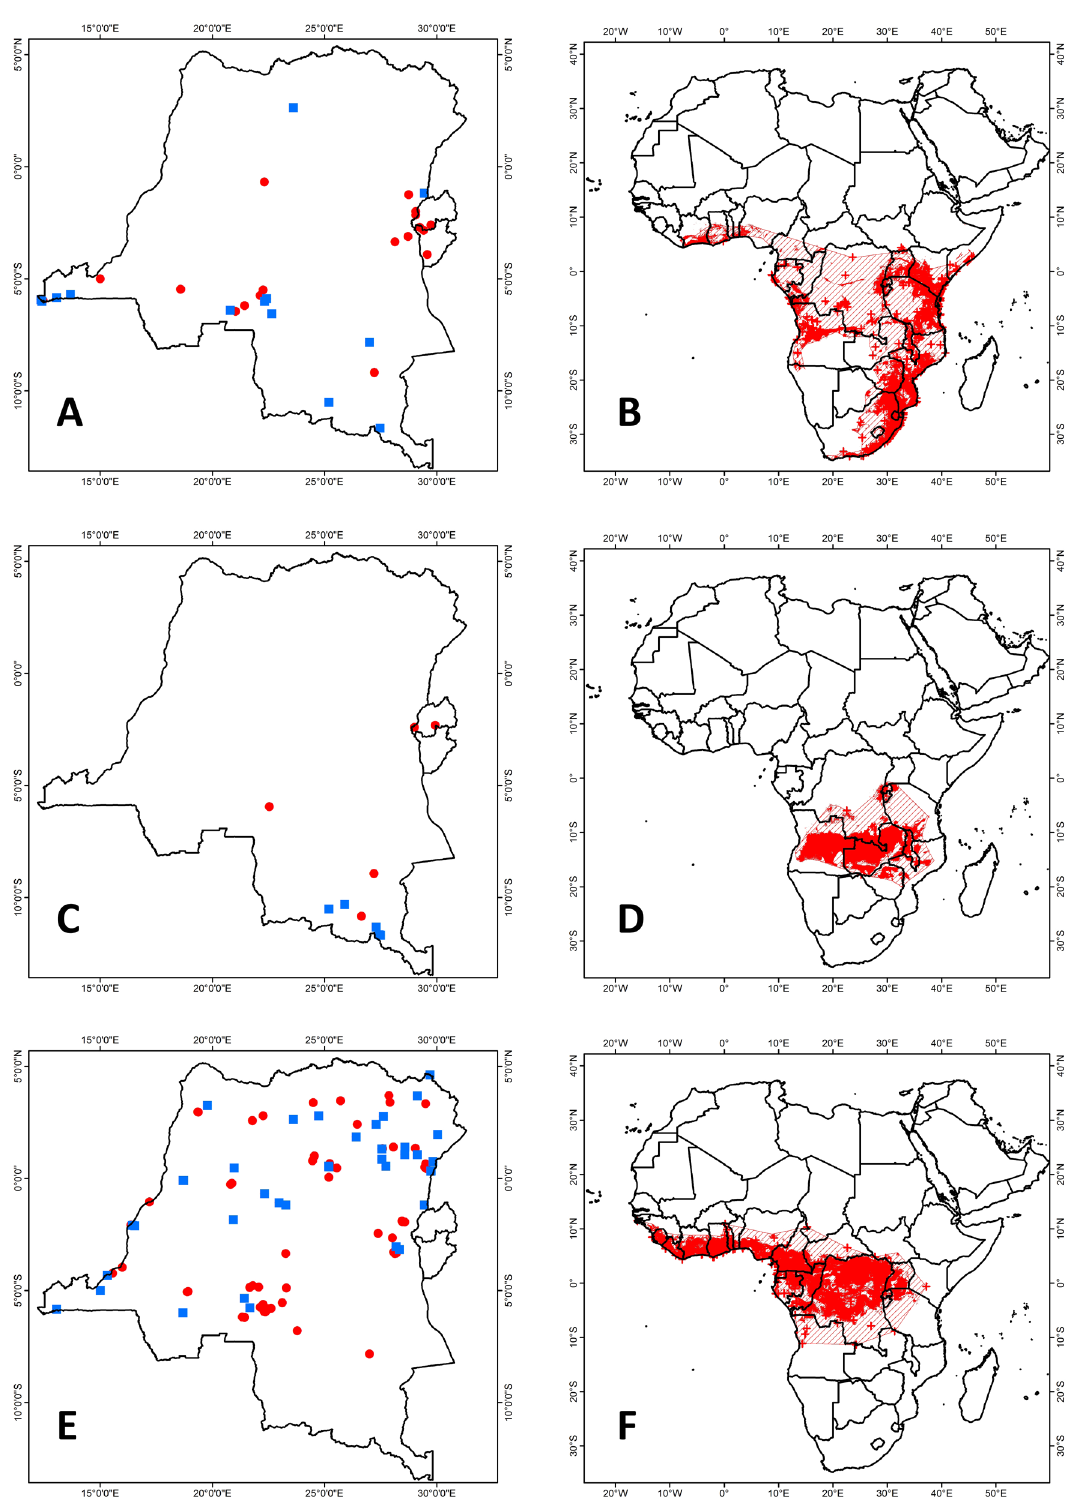
Fig. 5. Distribution maps. A–B . Epomophorus wahlbergi (Sundevall, 1846). C–D . Epomops dobsonii (Bocage, 1889). E–F . Epomops franqueti (Tomes, 1860). A, C, E. Distribution in the CRB area. B,